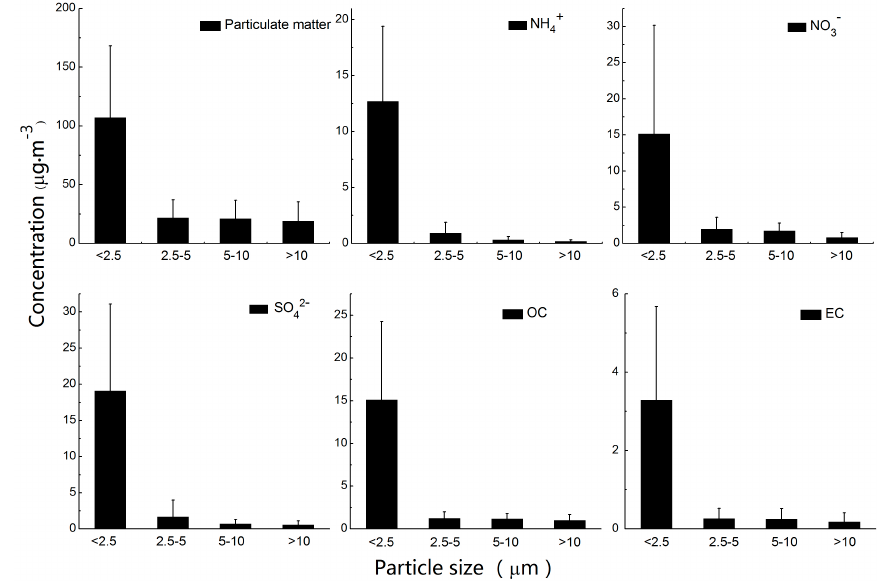
Figure 2. Mass concentrations of the atmospheric particles and major components at different size ranges in suburban Nanjing.